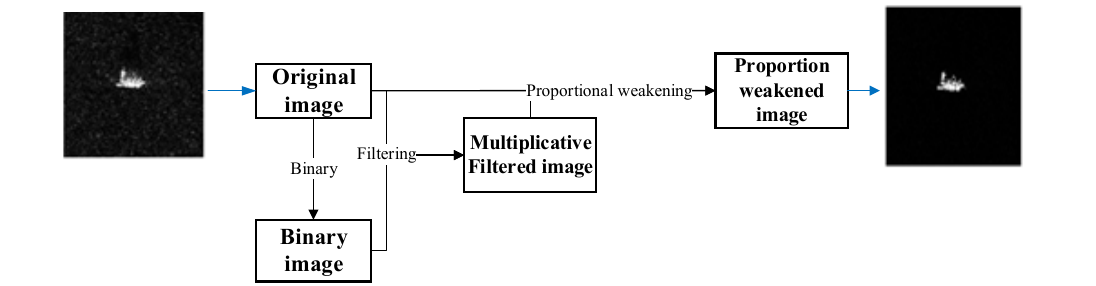
Figure 2. Flow of ADMF image processing method.